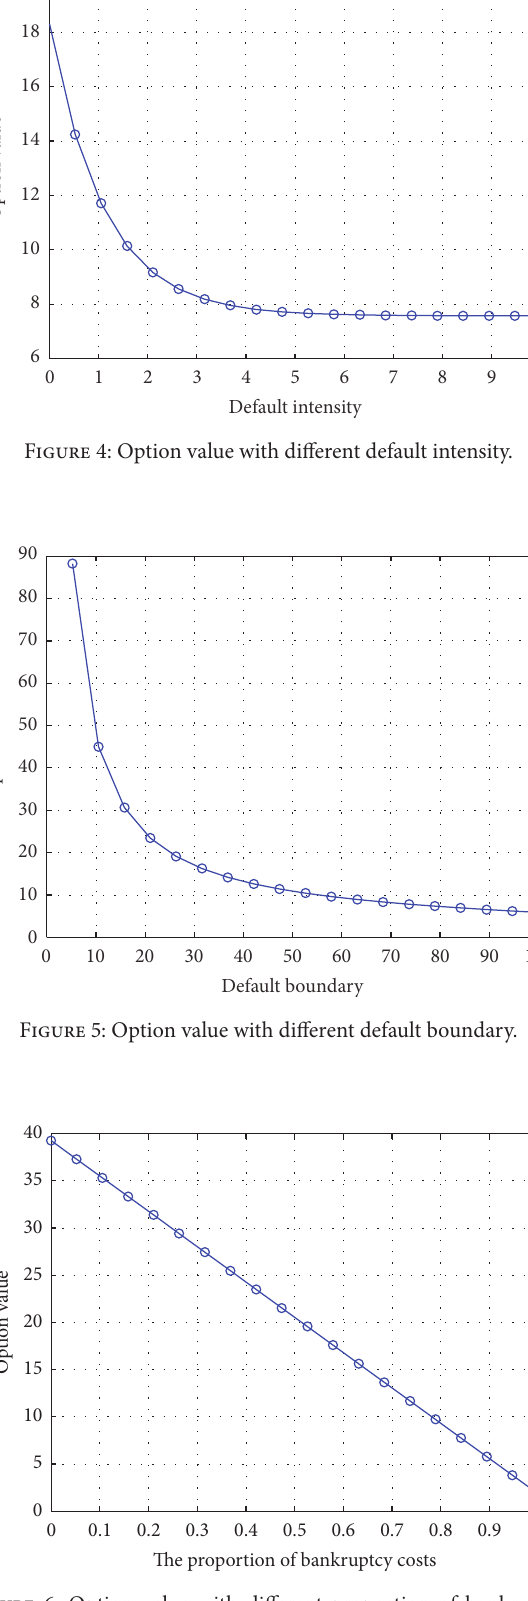
Figure 6: Option value with different proportion of bankruptcy